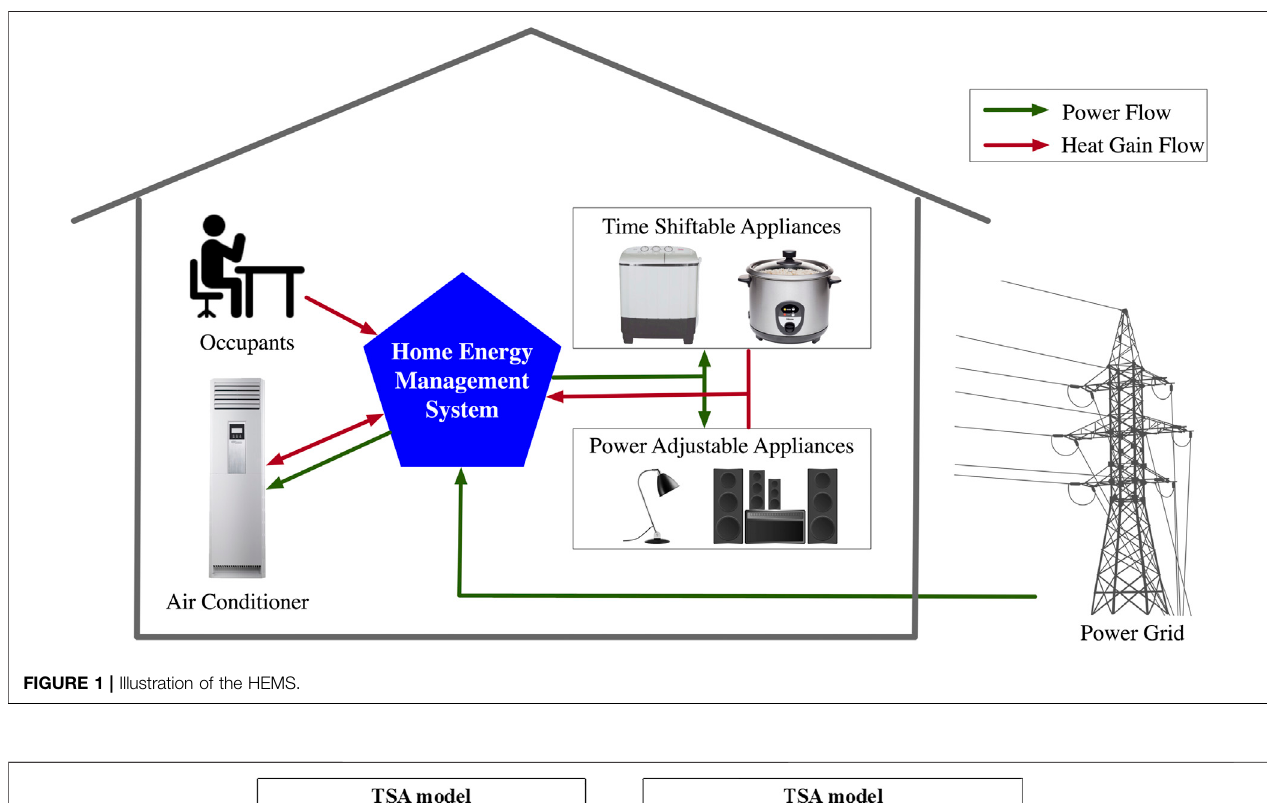
FIGURE 1 | Illustration of the HEMS.